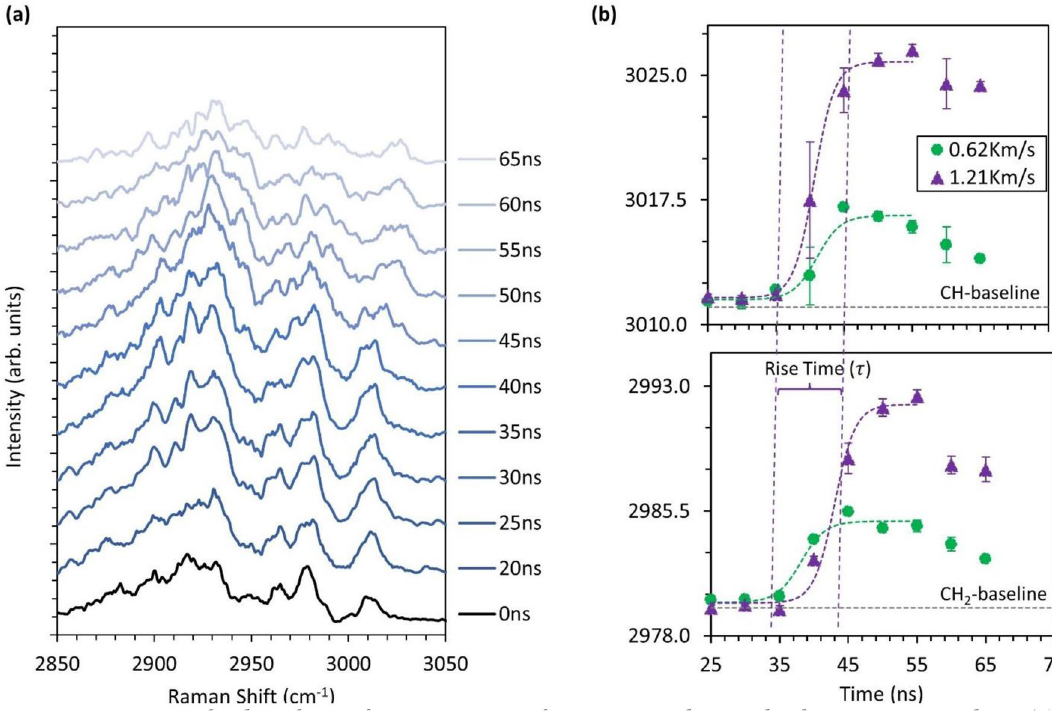
Figure 4. Time-resolved analysis of Raman spectra from sucrose during shock compression where ( a ) shows the time-evolution of Raman spectra of sucrose during impact at 1.21 km/s and ( b ) shows the change in peak location of CH 2 and CH functional groups in sucrose under shock compression during impact at speeds of 0.62 km/s and 1.21